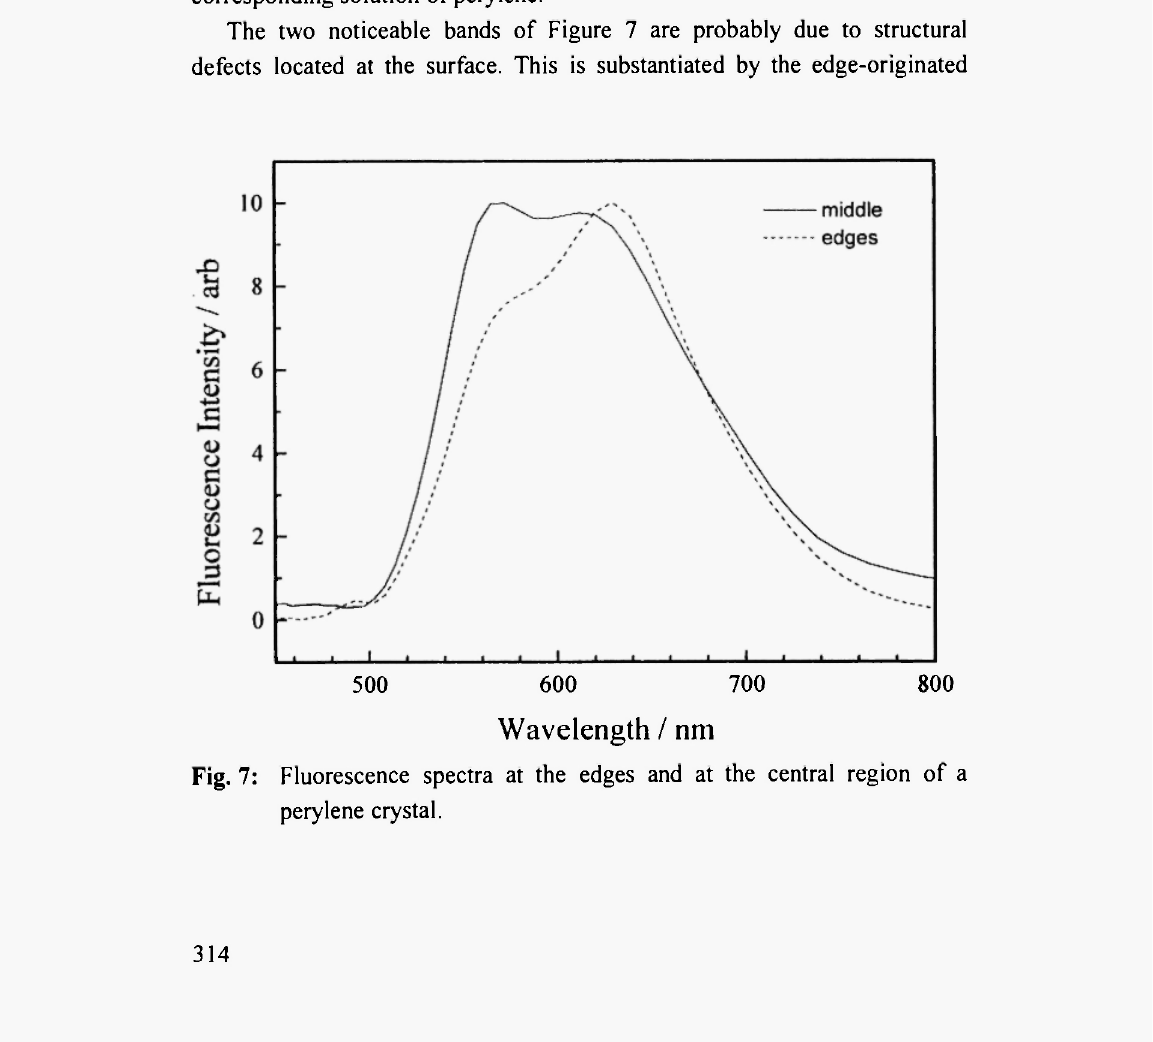
Fig. 7: Fluorescence spectra at the edges and at the central region of a perylene